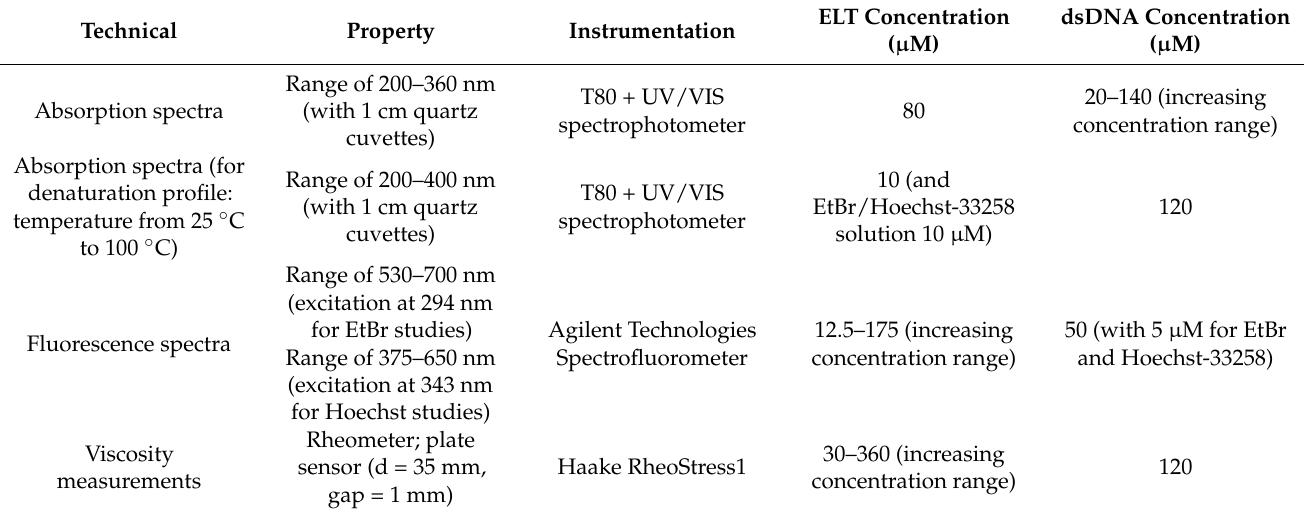
Table 1. Physical measurements and instrumentation conditions.